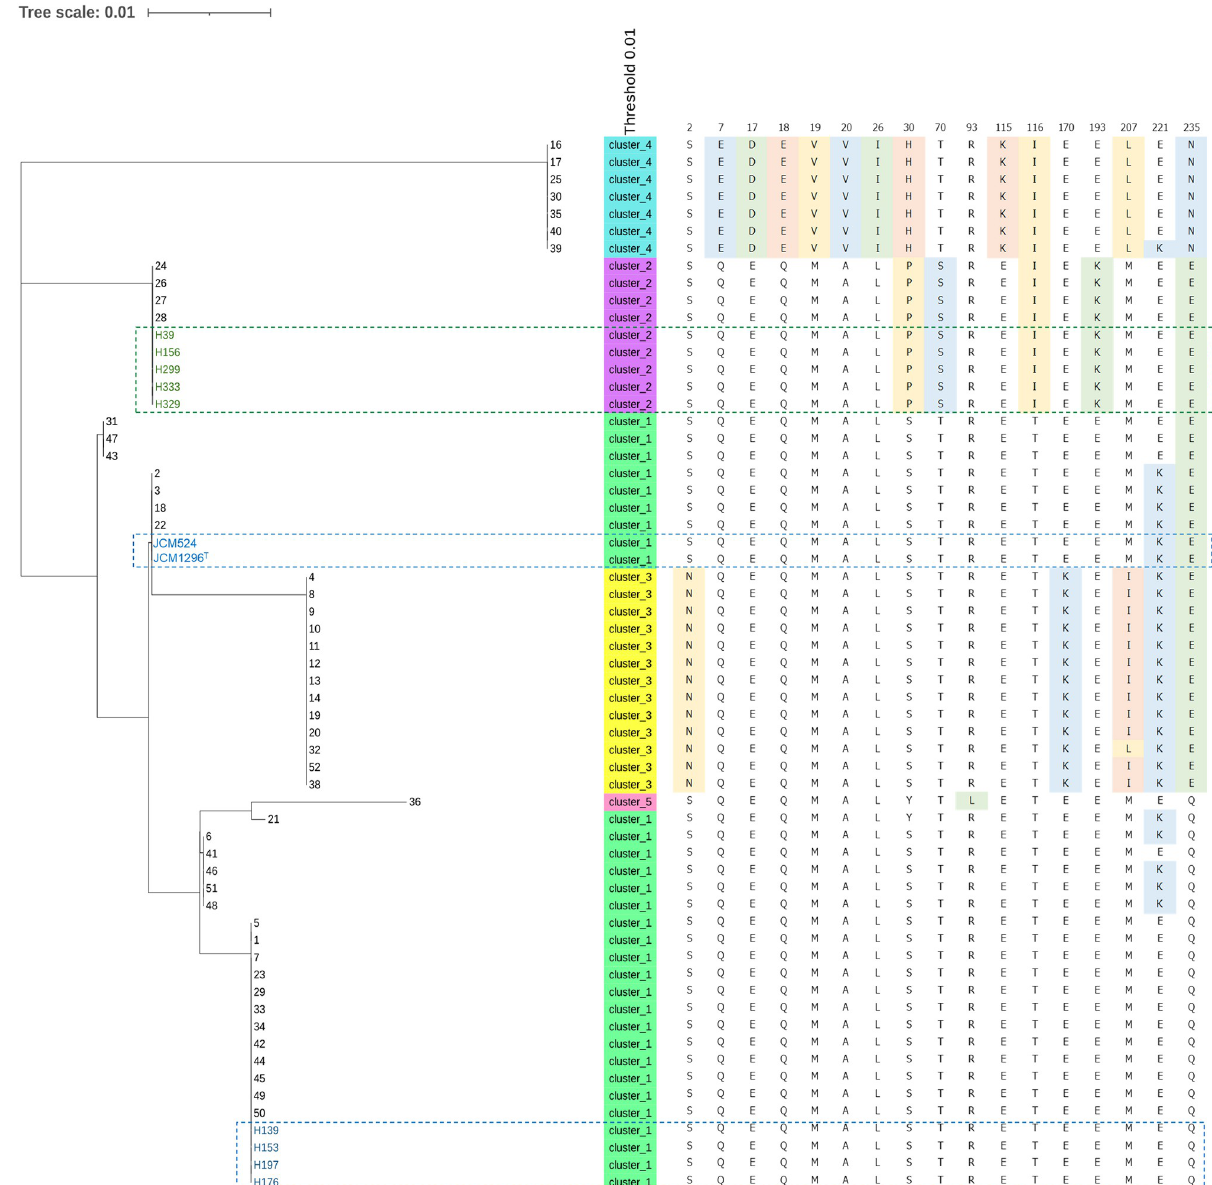
Fig 8. Phylogenetic analysis of CprA among 61 C . difficile strains. A phylogenetic tree was constructed with 11 the genome sequences determined in this study and 50 sequences obtained from the NCBI database. The blue-dashed square and green-dashed square show strains in Group 1 and Group 2,